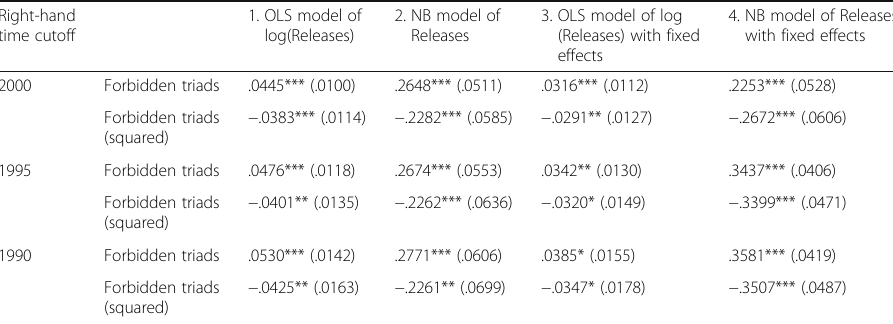
Table 8 Forbidden triads coefficients from statistical models of success with varying right-hand time cutoff Right-hand time